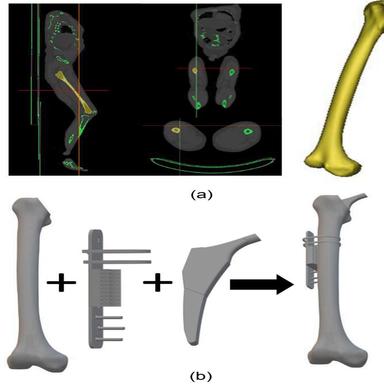
(a) The generation of femur bone from CT data, and (b) virtual positioning and operation of the CAD files of fracture fixation assembly, femoral implant, and scaffold device with the femur bone.